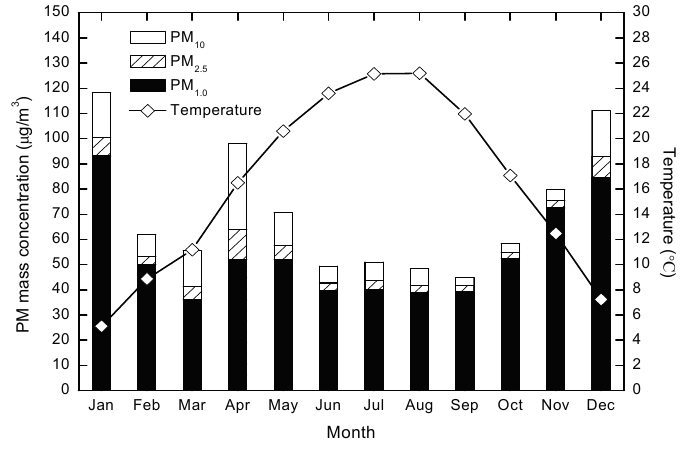
Figure 6. Variations in monthly mass concentrations of PM 10 , PM 2.5 and PM 1.0 related to temperature.